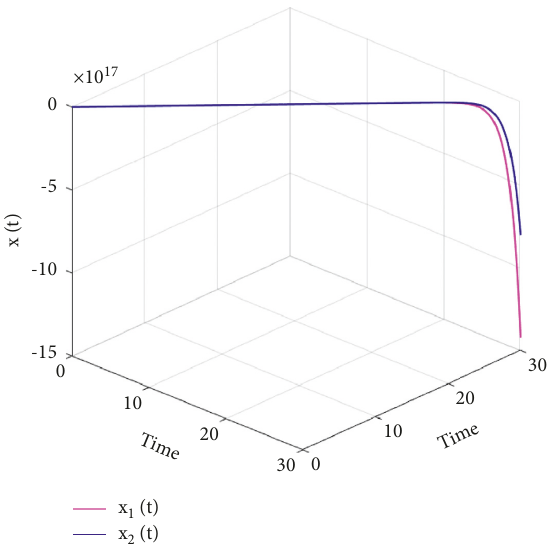
Figure 4: State responses of the original system without control.